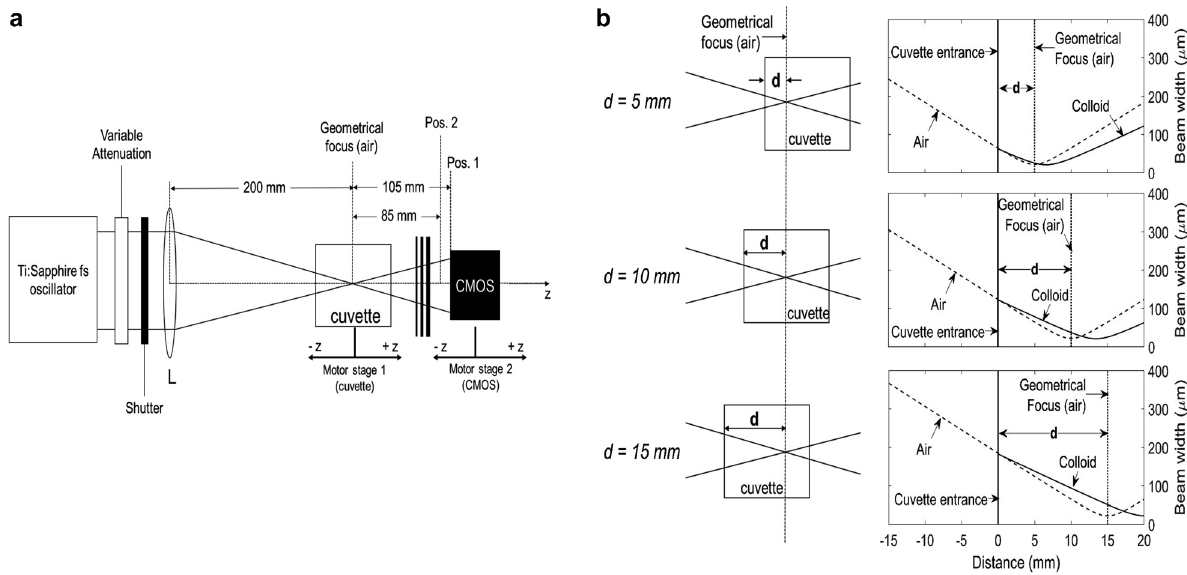
Figure 1: (a) The experimental setup (detailed in Supplementary material). (b) The fi gures on the left show the three examined cuvette positioningswithrespecttothegeometricalfocusoflensLinair,asde fi nedbytheparameter d .The fi guresontherightindicatequantitatively the shift of the actual beam waist position inside the 20 mm long cuvette, when fi lled with the examined colloids (linear regime). This is because of the difference between the refractive index of air ( n 0 ≈ 1) and colloids ( n 0 ≈ 1.33). The values in air (dashed curves) correspond to experimentally measured beam width along X -axis (shown in Figure A1(b), Supplementary material). The values in the colloids (solid curves) have been evaluated by Eq. (A1b) (Supplementary material) for n 0 = 1.33.